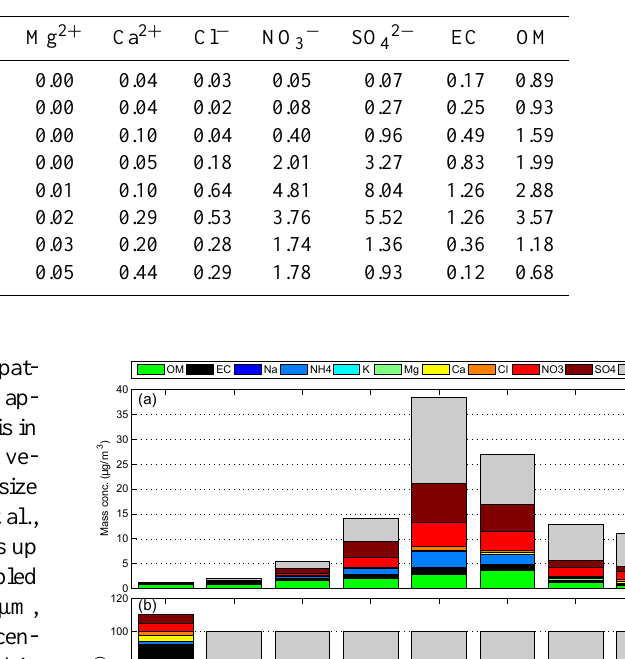
Table 3. The average particle chemical composition during the HaChi summer campaign. All mass concentrations are in the unit of micro- grams per cubic meter.